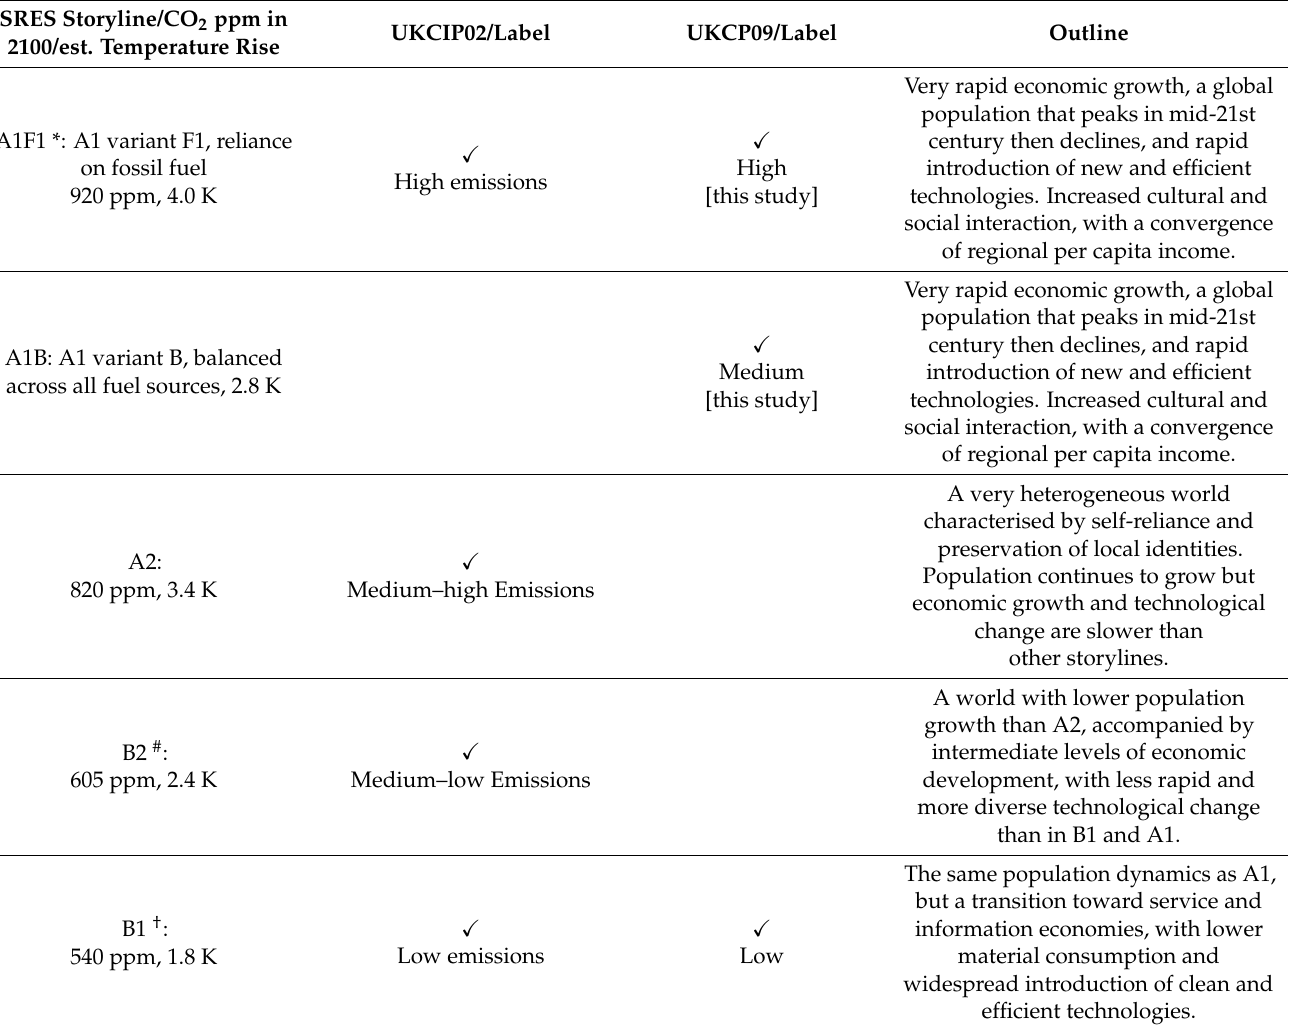
Table 2. Emission scenarios used in UKCIP02 and UKCIP09 modelling of future climate, from Appendix 5 (p107) [26], and [28,29]; ticks indicate inclusion of scenario in UKCIP data. Notes indicate nearest UKCP18